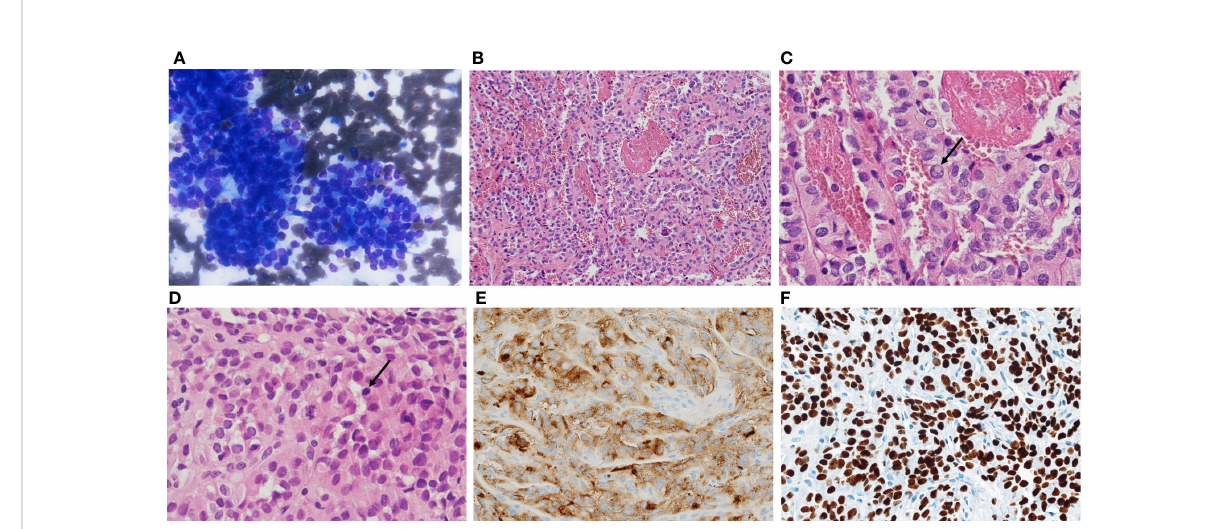
FIGURE 1 (A) fi ne needle aspiration showing atypical cells forming papillary clusters, diagnosed as TIR5-SIAPEC (Bethesda VI and to Thy5-BTA), compatible with papillary thyroid carcinoma. Histologically the tumor showed complex papillary architecture (B) intranuclear inclusions ( C , arrow), mitotic activity ( D , arrow), immunohistochemical thyroglobulin (E) and TTF1 expression (F) .